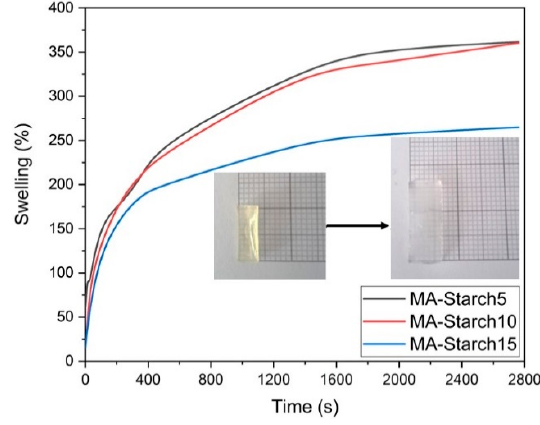
Figure 5. Swelling behavior of the three MA-Starch derived hydrogel formulations. Table 1. Properties of Starch-reference, MA-Starch, and MA-Starch hydrogels. Hydrogel Starch MA-Starch MA-Starch5